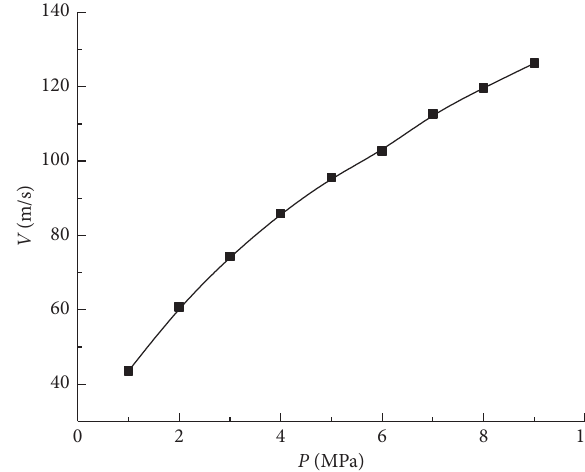
Figure 10: Characteristic pressure-flow